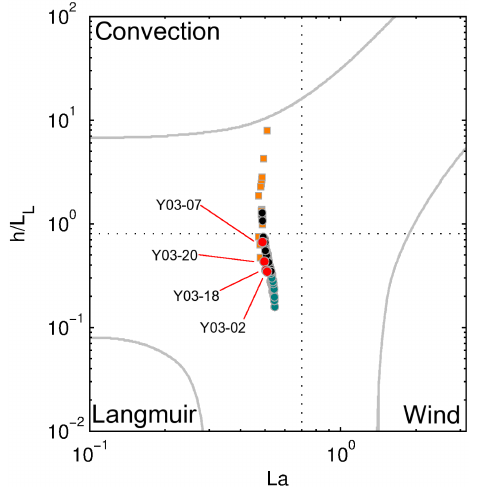
Figure 5. Regime diagram of turbulence forcing computed at the VIDA buoy from 2 February (14:30UTC) to 4 February (12:00UTC). Green and orange squares represents values before and after the Y03, red marks are the values for the ensembles shown in Fig. 9. The horizontal dashed line indicates the demarcation be- tween convection dominated turbulence and shear stress dominated one; the vertical dashed line shows demarcation between conven- tional wind stress-driven turbulence and Stokes production-driven one.